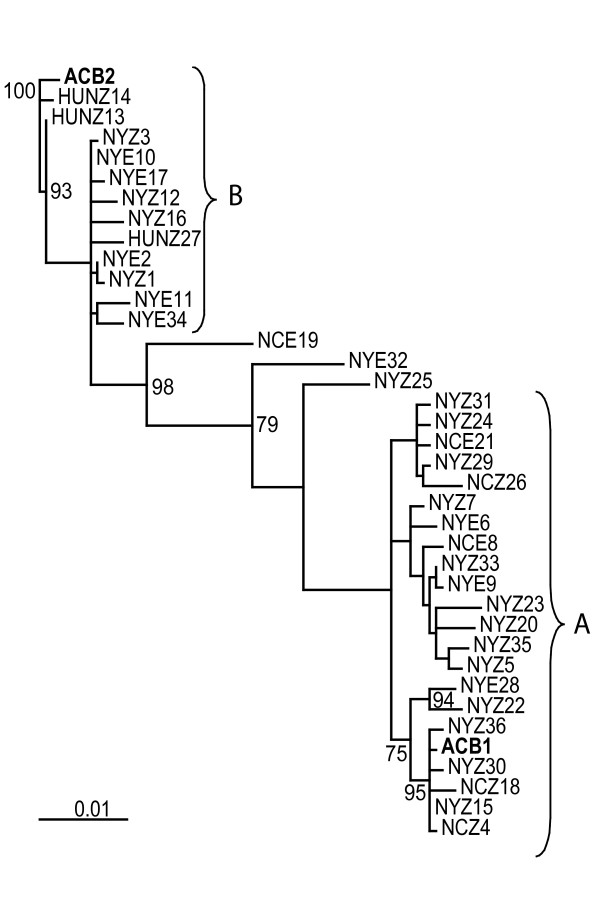
Δ11 desaturase gene genealogy for ECB, using ACB as an 'outgroup'. Shown is the maximum parsimony gene genealogy with ACB sequences labeled in bold and major clades denoted "A" and "B". ECB individuals are labeled with abbreviations for states or countries (NY = New York, NC = North Carolina, HUN = Hungary) and with Z or E to indicate to which pheromone strain they belong. ACB2 was chosen as an outgroup (as opposed to ACB1) because ACB2 is similar to ECB alleles from the European population in Hungary. Bootstrap values are indicated based on analysis using 1,000 replicates. Values less than 75% are not shown.